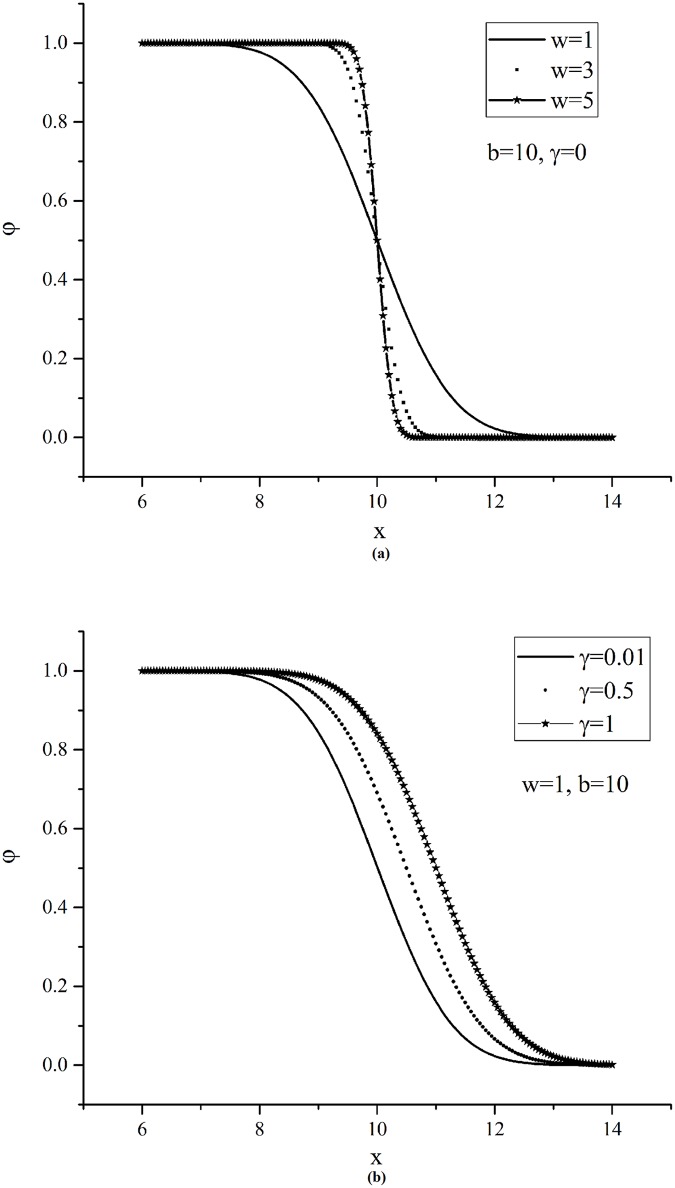
The impacts of scale and location parameters.The impacts of scale and location parameters on considered probability function are displayed separately by changing the values.